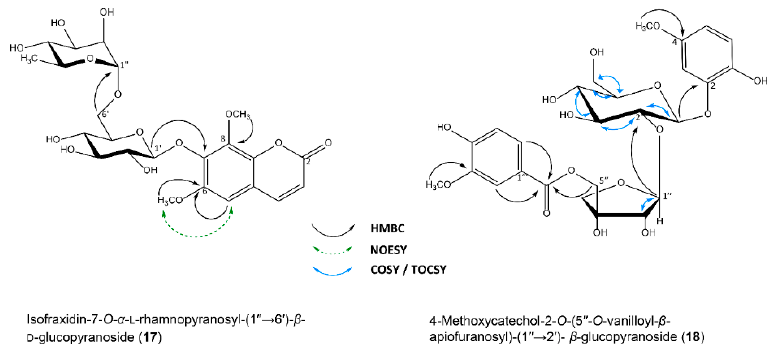
Figure 4. HMBC, NOESY and COSY/TOCSY key correlations for compounds 17 and 18 .